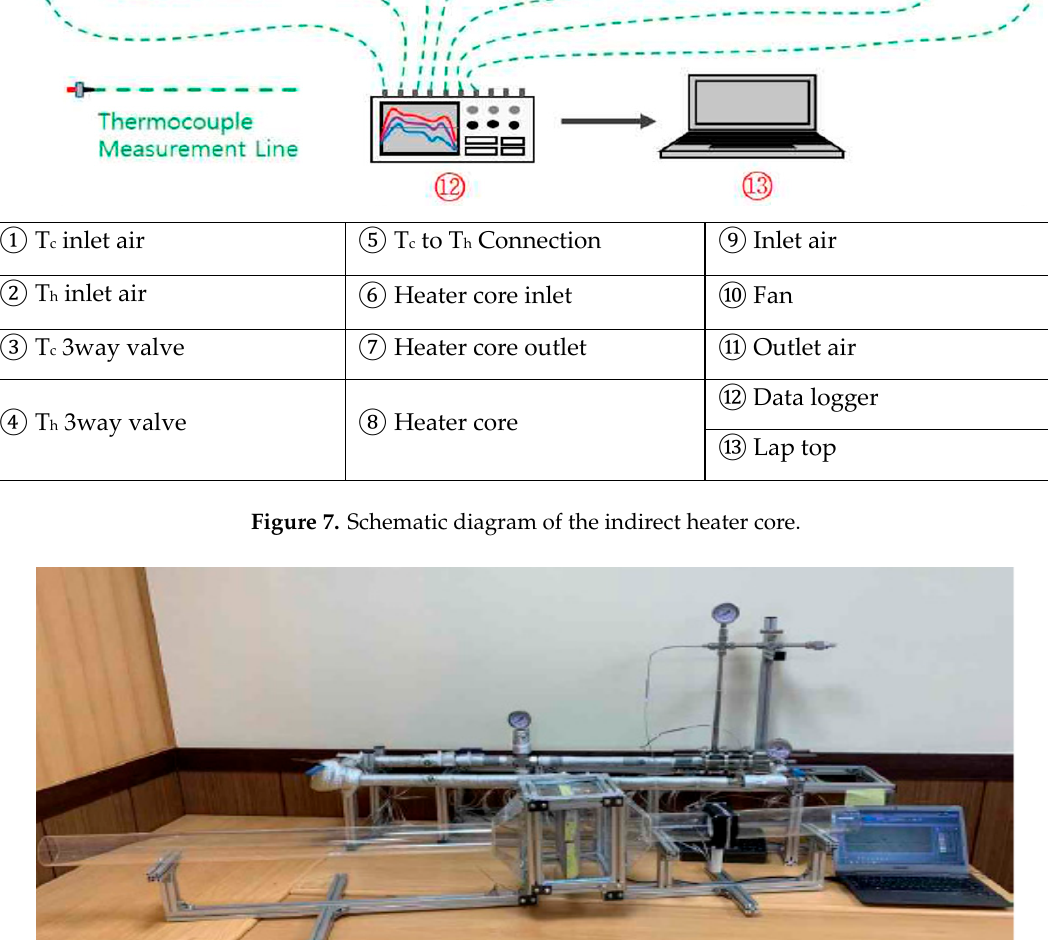
⑫ Lap top Figure 9. Schematic diagram of the direct air conditioning filter.